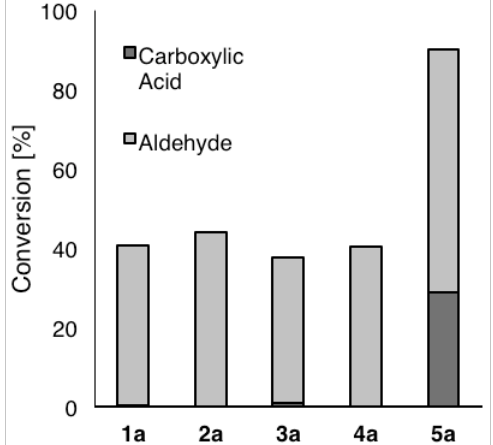
Figure 2. Oxidation of benzylic alcohols 1a – 5a (25 mM) by HMFO (wild type, 0.7 µM) in sodium phosphate buffer (100 mM, pH 7.0) at 30 °C with atmospheric oxygen in the presence of catalase after 24 h.